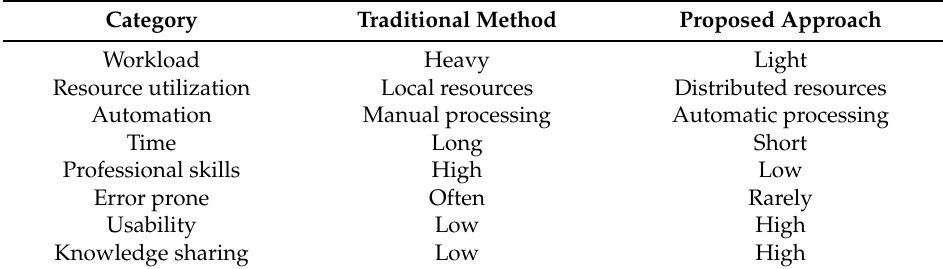
Table 1. The advantages of the proposed